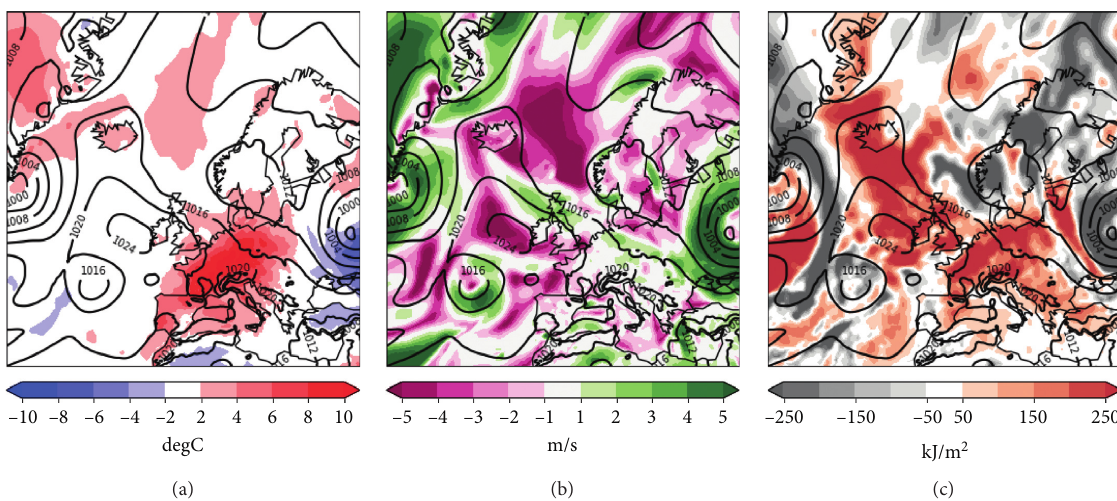
Figure 7: Meteorological anomaly of the 2003 heatwave event: (a) 2m temperature, (b) 100m wind speed, and (c) surface solar